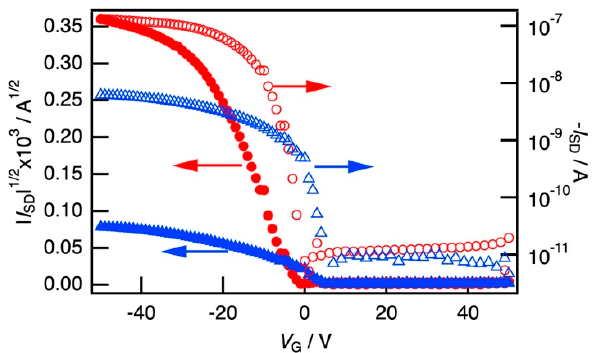
Figure 5. Transfer characteristics of the film of P3HT nanofiber composited in PB / PEG blend with ϕ PB below ( ϕ PB = 0.40; filled and open triangle) and above ( ϕ PB = 0.72; filled and open circle) the critical threshold ϕ c I . In both cases, a typical p-type property was observed, showing marked amplification of I DS with respect to the negative gate voltage V G . µ increased by an order of magnitude at ϕ c I .